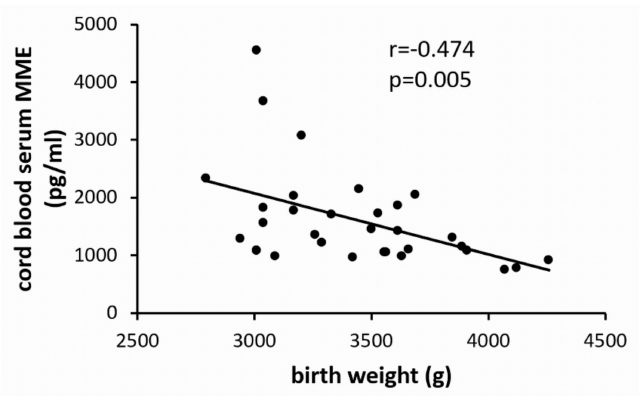
Figure 4. Correlation of umbilical cord blood serum MME levels with birth weight ( n = 32). 2.4. MME Protein in fpEC was not Regulated by Oxygen and Tumor Necrosis Factor α (TNF α ) Hypoxia and NF- κ B (nuclear factor kappa B) signalling downregulate MME in other cell types [19–21], and TNF α (tumor necrosis factor α ) is an activator of NF- κ B signaling [22]. Thus, we tested whether oxygen or TNF α altered MME in fpEC from control pregnancies. However, after 48 h, MME protein did not differ between cells grown at 5%, 12%, and 21% oxygen (Figure 5A). Additionally, TNF α treatment (5 and 50 ng / mL) did not affect MME after 24 h (Figure